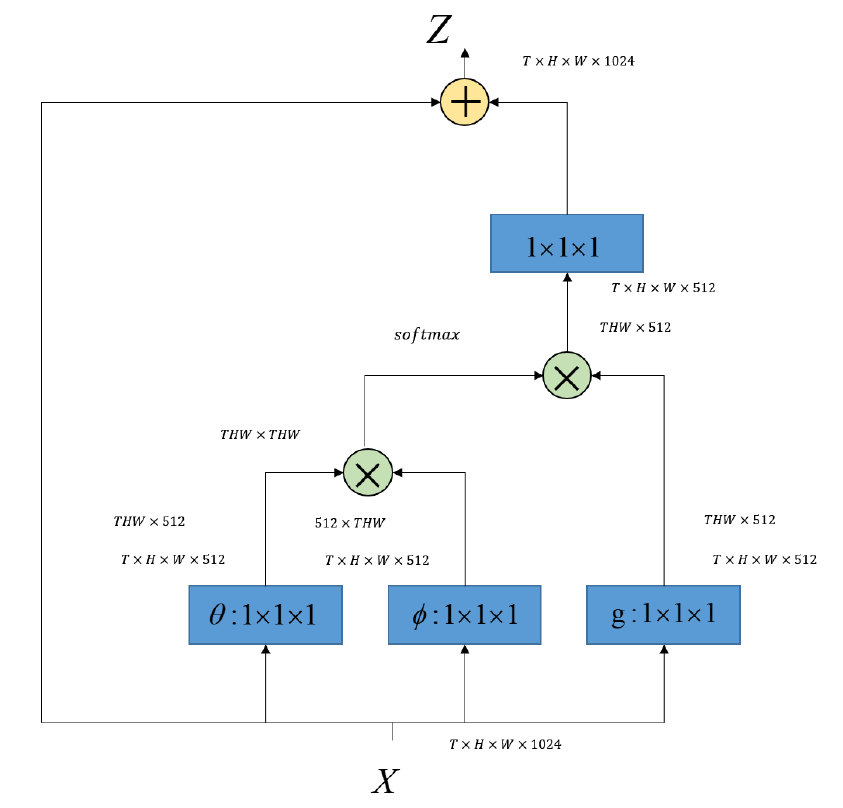
Figure 3. Non-local